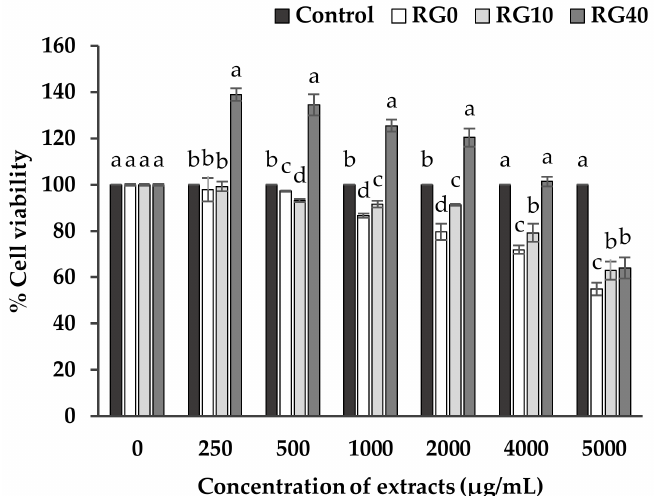
Figure 4. Cell viability and cell proliferation of RAW264.7 murine macrophage cells after incubating with various concentrations of extracts from 250–5000 µ g/mL for 24 h: RG0; ricegrass juice extract (control), RG10; ricegrass juice fortified with 10 mg Se/m 3 extract, RG40; ricegrass juice fortified with 40 mg Se/m 3 extract. Data are means ± standard deviation (SD). Different letters indicated significant differences ( p < 0.05) in Duncan’s significant differences